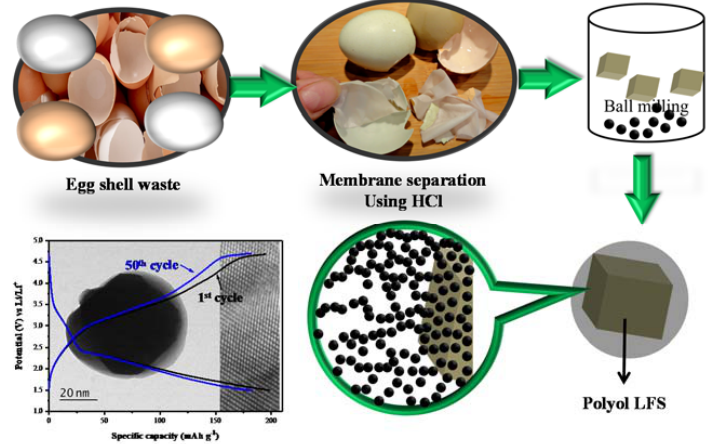
Figure 1. Schematic representation of LFS@ESM.